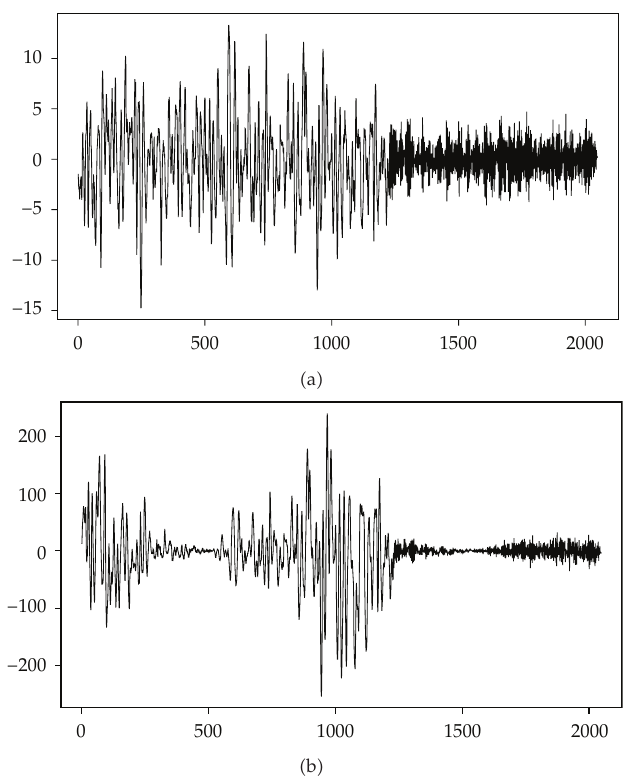
Figure 5: Example 5.2: (cid:5) a (cid:6) input series and (cid:5) b (cid:6) output